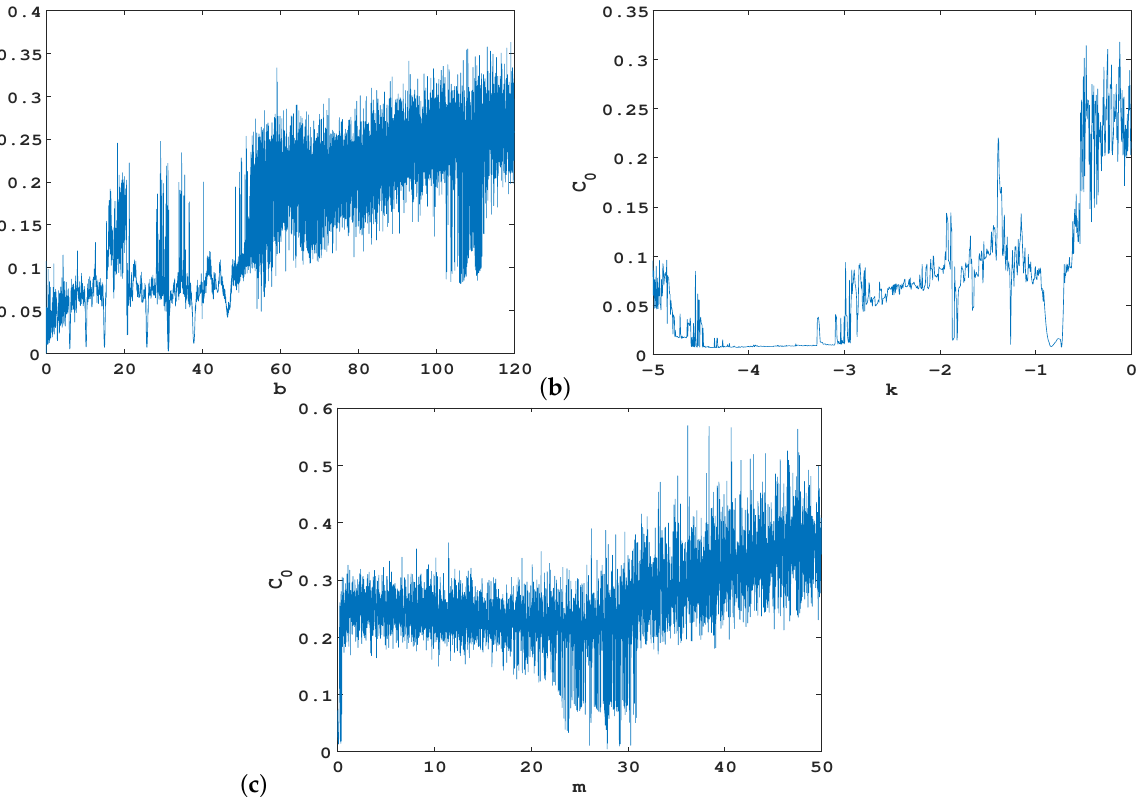
Figure 7. C 0 complexity curve of the new system (2). ( a ) Versus b for a = 10, c = 2.7, k = − 0.2, m = 1; ( b ) versus k for a = 10, b = 100, c = 2.7, m = 1; ( c ) versus m for a = 10, b = 100, c = 2.7, k = − 0.2. The initial values were set as ( 1.67610, − 0.37856,3.69140,1.45851 )